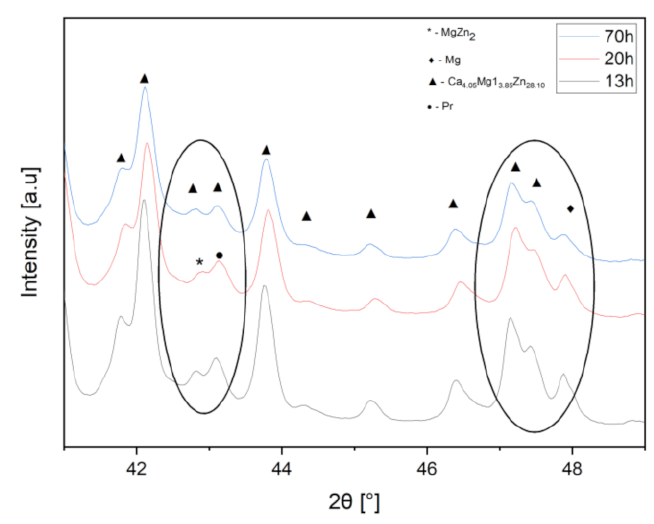
Figure 4. Magnification of the selected region (41–49 ◦ 2 θ ) of the phase analysis of the Mg-Zn-Ca-Pr alloy samples sintered from milled (70 h)